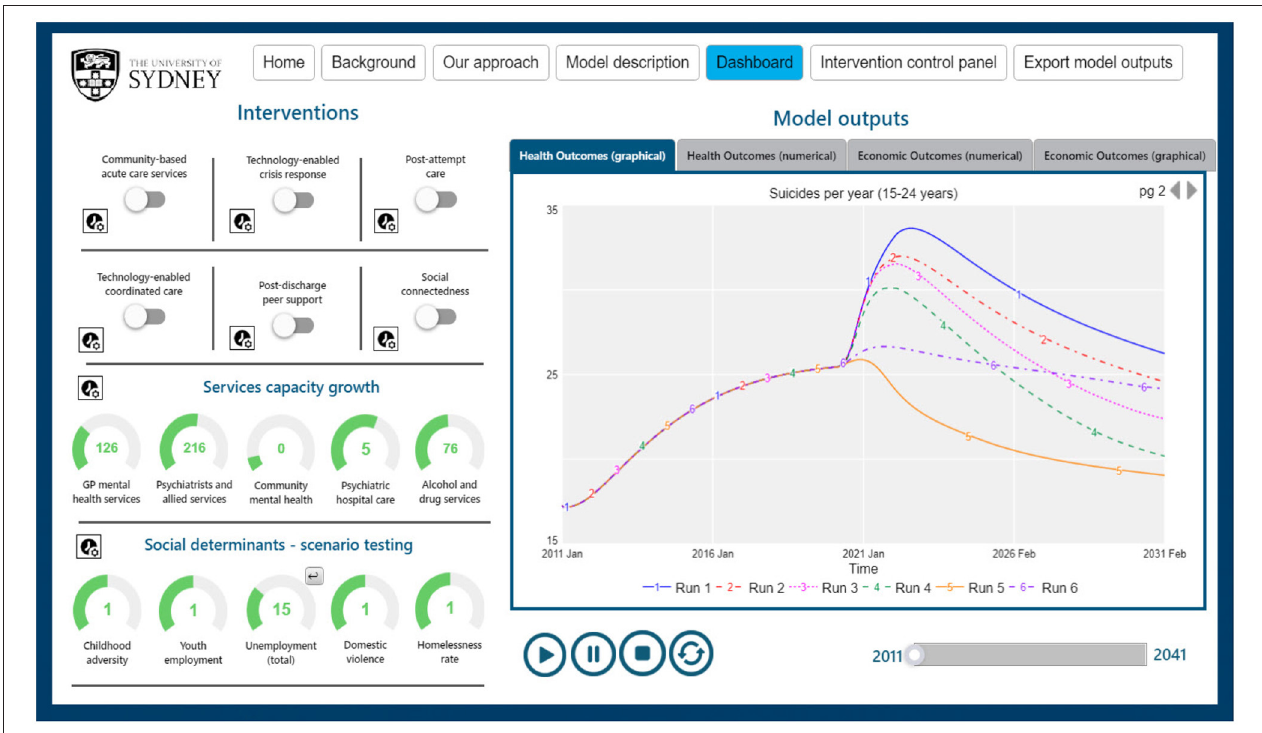
FIGURE 1 | Interactive user interface to facilitate scenario testing and inform decision making.